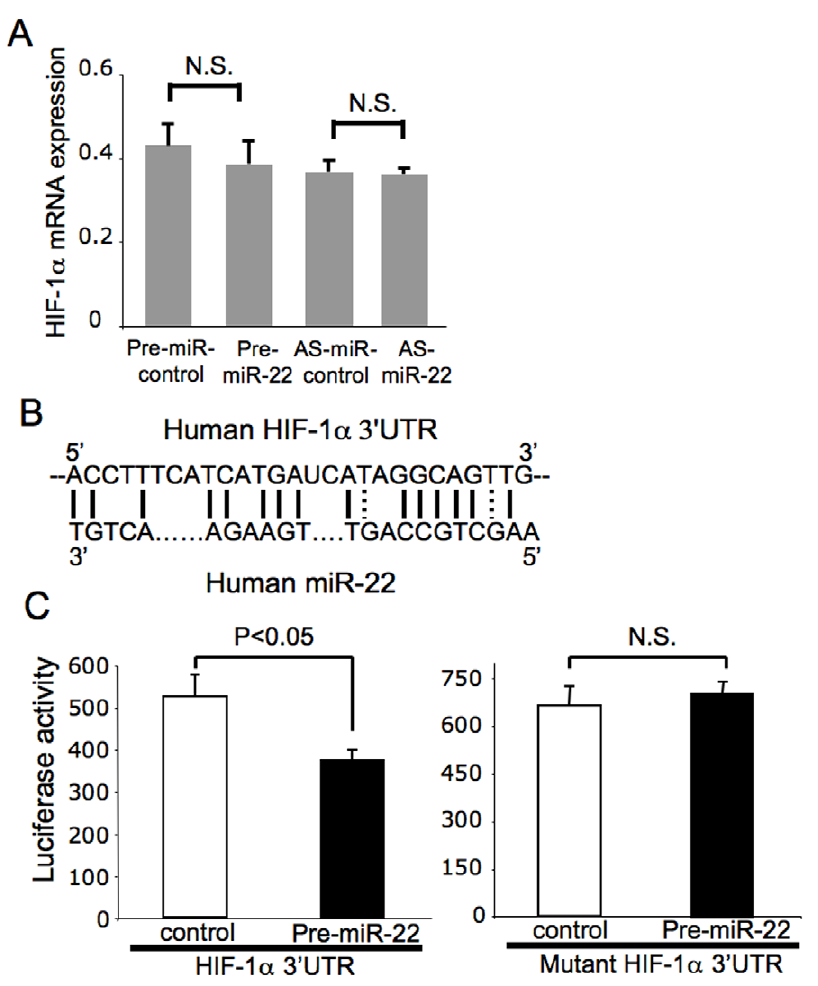
Figure 3. MiR-22 regulates HIF-1 a by inhibiting its translation. (A) MiR-22 does not affect HIF-1 a mRNA. HCT116 cells were transfected with Pre-miR-22 or anti-sense-miR-22 or control. Total RNA was harvested and analyzed for HIF-1 a mRNA by qPCR (n=3 6 S.D.). (B) Human HIF-1 a 3 9 UTR contains a binding site for miR-22. (C) MiR-22 represses transactivation of HIF-1 a 3 9 UTR. HCT116 cells were transfected with a luciferase reporter vector (MiRreport) containing the 3 9 UTR of HIF-1 a (left panel) or a mutated 3 9 UTR of HIF-1 a (right panel) and with pre-miR-22 or pre-miR-control. Cells were harvested and luciferase activity was measured (n=3 6 S.D.).